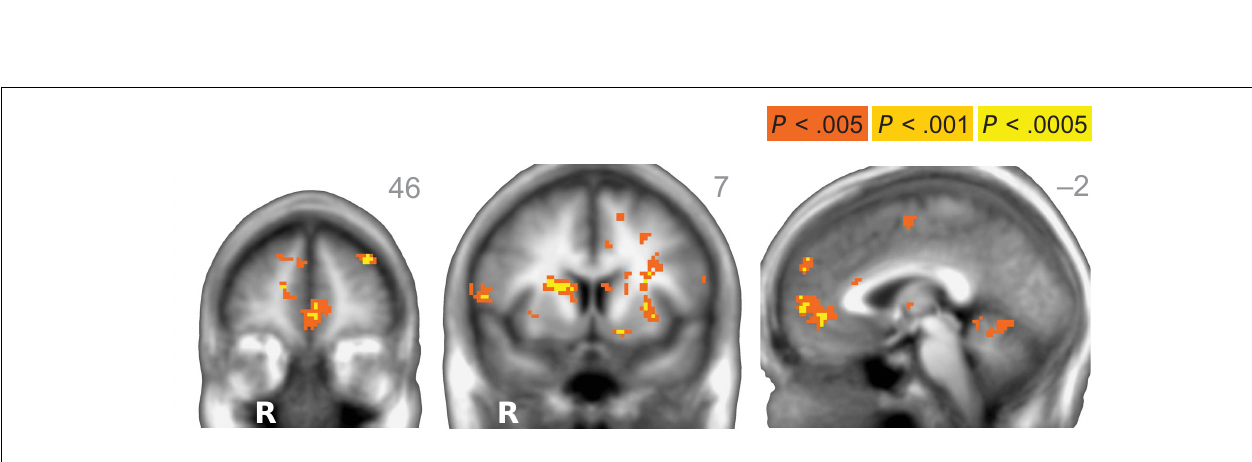
observed for the β regressor in the β – δ model) including the medial prefrontal cortex and striatum was correlated with subjective value (see TableA1 ). R = right. R/L or A/P, value listed in upper right corner of each statistical map. Anatomical underlay is an average of all subjects’ spatially normalized structural scans.